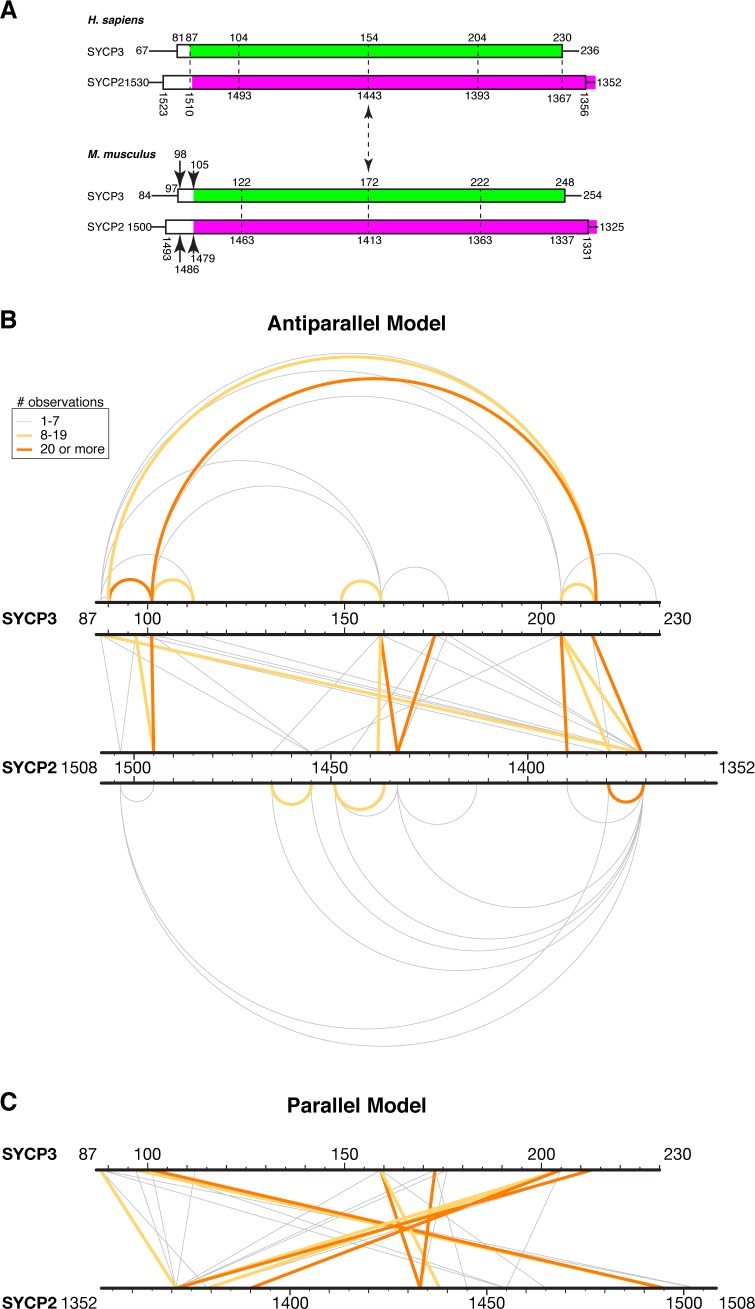
XLMS analysis of Hs SYCP3CC-SYCP2CC fusion.(A) Schematic model for the register of a hypothetical SYCP2:SYCP3 heterotetrameric complex, based on sequence alignments between the two proteins and the structure of Hs SYCP3CC (Syrjänen et al., 2014). (B) Schematic of 55 unique crosslinks (listed in Supplementary file 2–3) detected by crosslinking mass spectrometry (XLMS) mapped onto an antiparallel model of the SYCP2:SYCP3 complex. Top: 15 intra-SYCP3 crosslinks. Bottom: 13 intra-SYCP2 crosslinks. Middle: SYCP2-SYCP3 crosslinks. Crosslinks are colored by the number of times each was observed: 1–7 gray, 8–19 yellow, 20 or more orange. (C) Schematic of SYCP2-SYCP3 crosslinks mapped onto a parallel model of the complex.